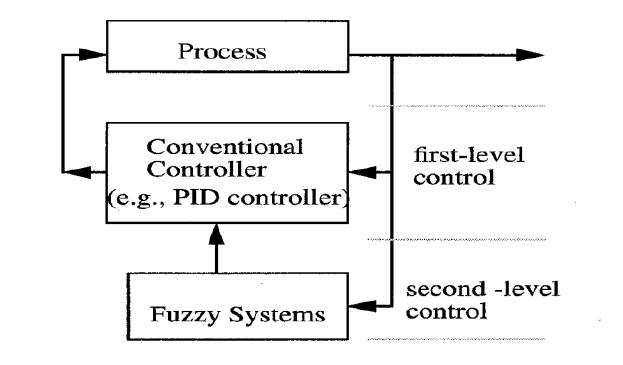
Fig. 4. Two level fuzzy supervisory control system